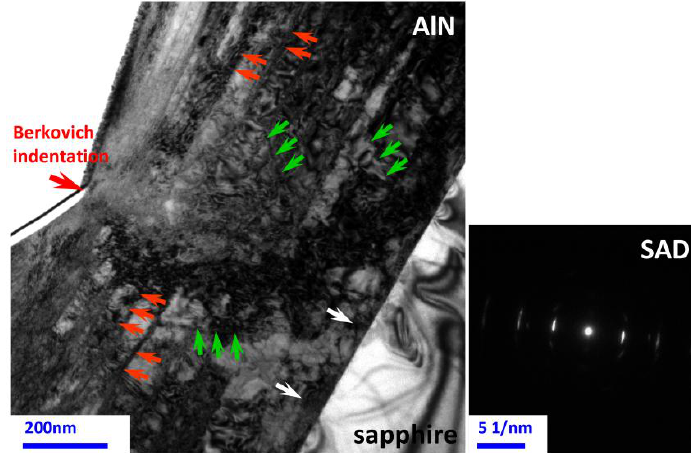
Figure 2. A bright-field XTEM image in the vicinity under the Berkovich indent applied on the AlN thin film with an indentation load of 100 mN. In addition, the selected area diffraction (SAD) pattern results of indented AlN thin film underneath the Berkovich